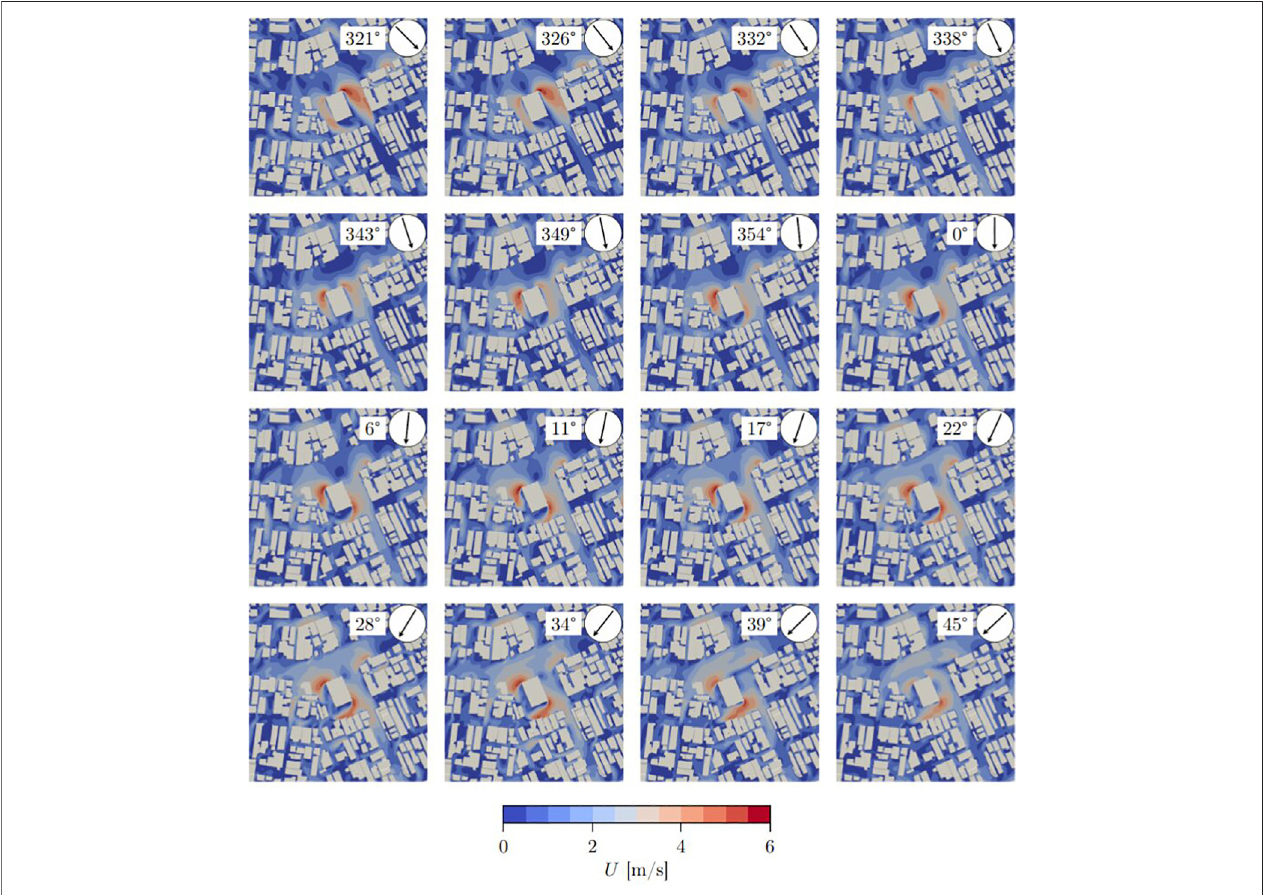
FIGURE 5 | Wind speed at 2 m above ground. The 16 included simulations represent wind from a 90 ° wide sector around the reference wind direction N (0 ° ). The compared area is within 100 m in each horizontal direction of the high-rise building and does not include the building footprint area. The black arrow indicates the wind direction at the